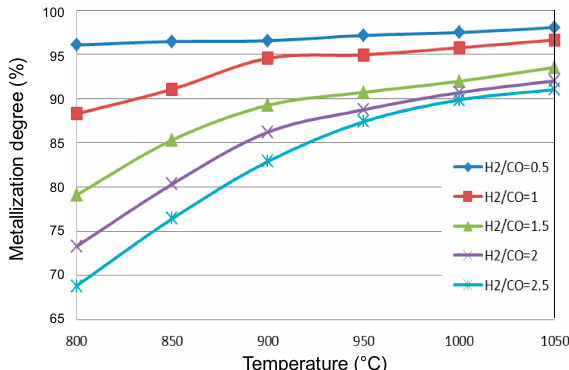
Figure 10. Metallization degree of the DRI at the exit of a MIDREX shaft furnace as a function of temperature and H 2 / CO ratio.